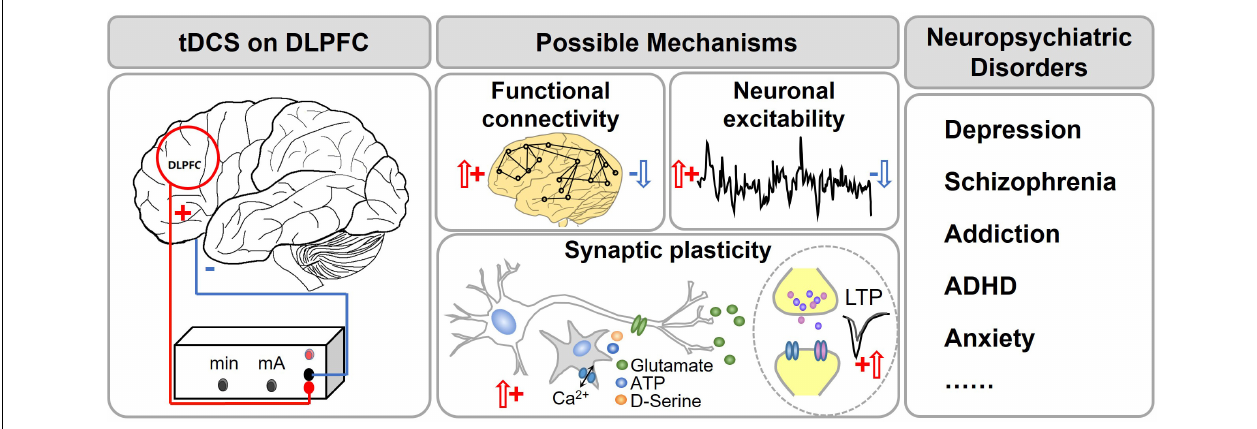
FIGURE 1 | tDCS of the dorsal lateral prefrontal cortex (DLPFC) for treatment of neuropsychiatric disorders. The red circle shows the DLPFC. It is the center for higher brain functions such as working memory, executive function, attention, etc. Dysfunction of DLPFC was found in many psychiatric disorders such as schizophrenia, depression, ADHD, etc. tDCS of DLPFC has become a popular treatment option for these disorders. It has been proposed that tDCS changes the functional connectivity, neuronal excitability and synaptic plasticity of the related brain